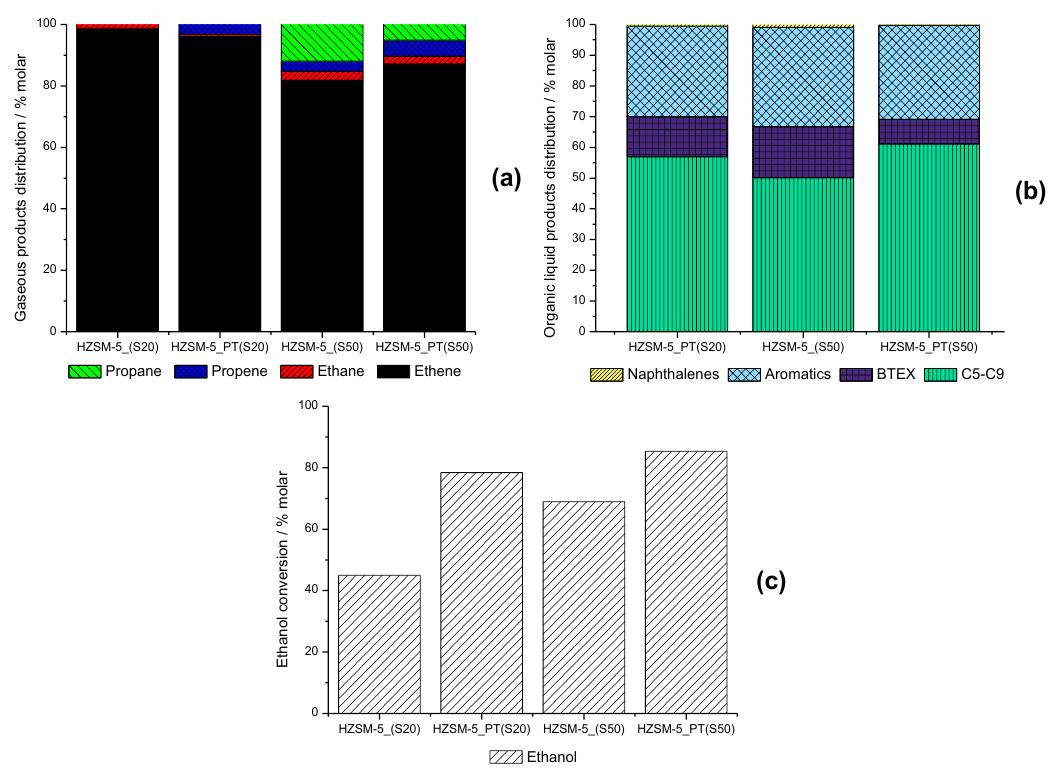
Figure 3. Product class distribution of the ( a ) gaseous fraction and ( b ) organic liquid fraction, and ( c ) ethanol conversion, for 360 °C, 15 bar, ~38 h − 1 , and 3 h TOS.